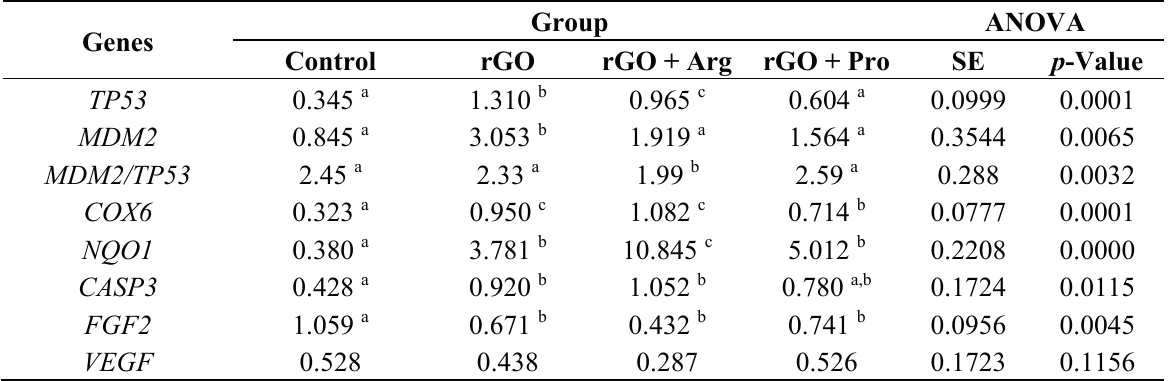
Table 2. Gene expression at the mRNA level in glioblastoma multiforme U87 tumors, cultured on chicken embryo chorioallantoic membrane, after treatment with reduced graphene oxide, reduced graphene oxide with arginine and reduced graphene oxide with proline or untreated as a